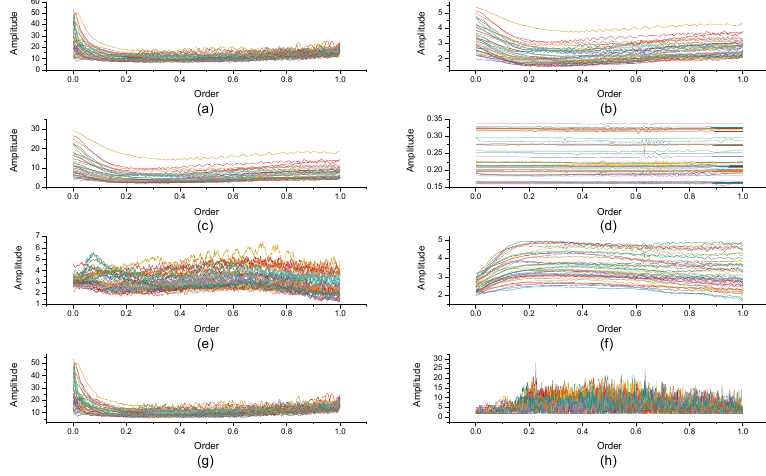
Figure 6. The Order–Amplitude figures of different features of 40 groups for the upstairs action. ( a ) range , ( b ) std , ( c ) var , ( d ) rms , ( e ) IQR , ( f ) mean , ( g ) pksMean and ( h ) pksNum .